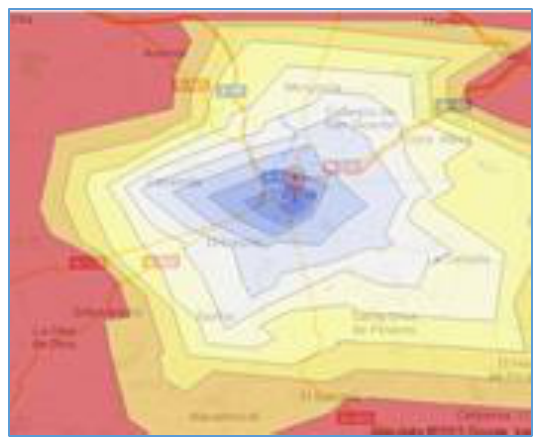
Figure 3. Isochrones over the capital city of